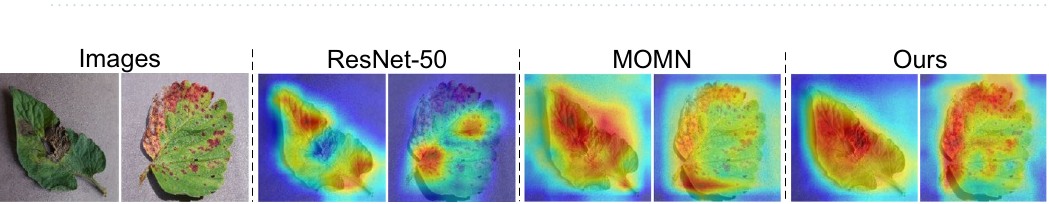
Figure 7. Feature map visualization of our method and two other methods based on the last convolution layer of ResNet-50